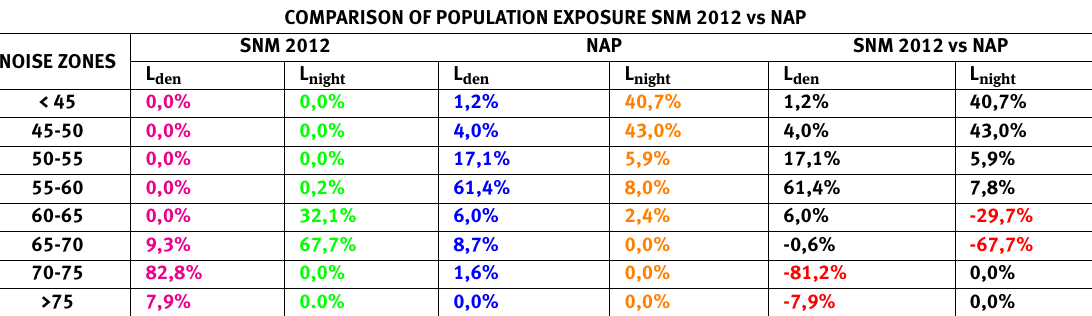
Table 7. Alikarnassos Study Area: Noise Action Plan vs Strategic Noise Map 2013 Comparative population noise exposure by environment noise